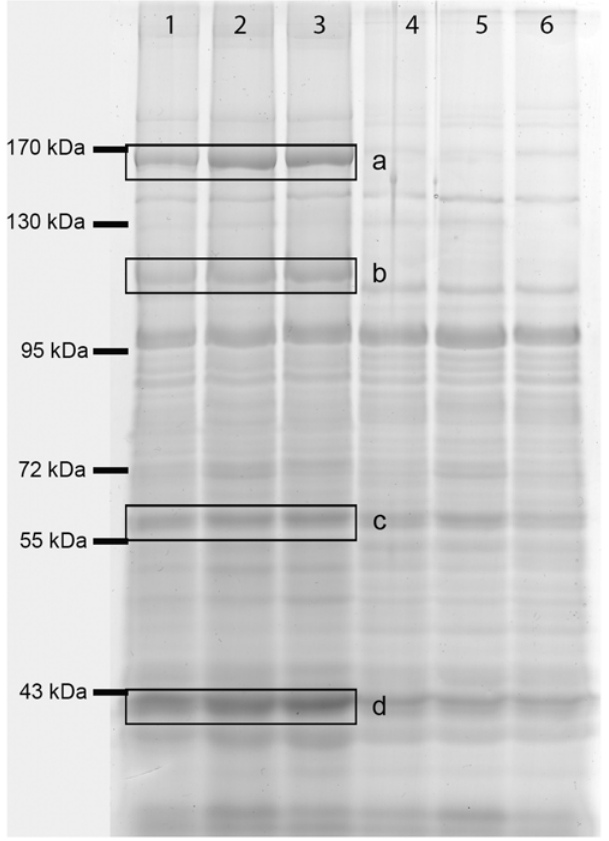
Figure 3. SDS-PAGE of the membrane fraction of P. protegens Pf-5 grown in presence and absence of FA. Triplicate cultures of P. protegens Pf-5 were grown aerobically for 12 h in E 2 glucose minimal medium with (1, 2 and 3) or without (4, 5 and 6) the addition of 2 mM FA. Aliquots containing 100 μ g of protein obtained from the total membrane fraction were loaded onto the gel. Boxed bands mark proteins whose levels differ in cells grown in the presence and absence of FA and were identified by peptide fingerprint analysis (a: Pyochelin synthetase F, b: Pyochelin synthetase E, c: ABC transporter ATP-binding protein, d: L-ornithine 5-monooxygenase